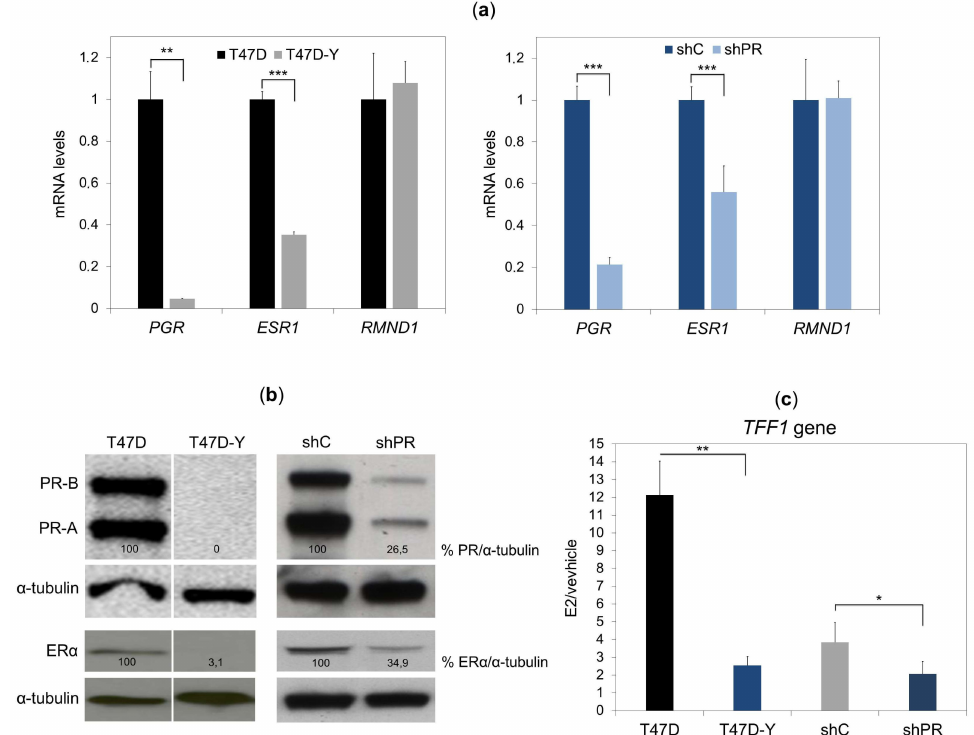
Figure 1. Loss of PR reduces the ESR1 expression in hormone-deprived T47D breast cancer cells. ( a ) Gene-specific mRNA expression measured by quantitative RT-PCR in T47D or PR-deficient cells (T47D-Y) (left panel ) and T47D cells transduced with shRNA against PR (shPR, clone trcn0000010776) or scramble shRNA (shC) (right panel). The gene-specific expression levels were normalized to GAPDH expression and are represented as relative values in the T47D cells. RMND1 was used as a PR-independent control. PGR , PR-encoding gene; ESR1 , ER-encoding gene. Error bars represent the SD of three independent experiments. ** p less than or equal to 0.01, *** p less than or equal to 0.005, unpaired two-tailed Student’s t -test. ( b ) PR and ER α protein levels measured by Western blot in T47D and T47D-Y cells (left panel) and in T47D transduced with shRNA against PR (shPR; clone trcn0000010776) or scramble shRNA (shC) (right panel). α -tubulin protein was used as the loading control. The intensities of the PR and ER bands were normalized to α -tubulin and represented as the relative value in the control cells. The vertical white line depicts a removed lane between the two samples. Blots are representative of three independent experiments. ( c ) PR depletion impairs TFF1 estrogen-mediated gene transcription. T47D cells, PR-deficient (T47D-Y) cells, short hairpin control (shC) and PR-depleted cells (shPR, clone trcn0000010776) were treated with estradiol (E2, 10 nM) or ethanol (vehicle) for 6 h, at which point TFF1 mRNA expression was measured by quantitative RT-PCR. The TFF1 gene expression was normalized to GAPDH expression and is represented as fold change relative to the vehicle (E2/vehicle). Error bars represent the standard deviation (SD) of three independent experiments. * p less than or equal to 0.05, ** p less than or equal to 0.01, unpaired two-tailed Student’s t